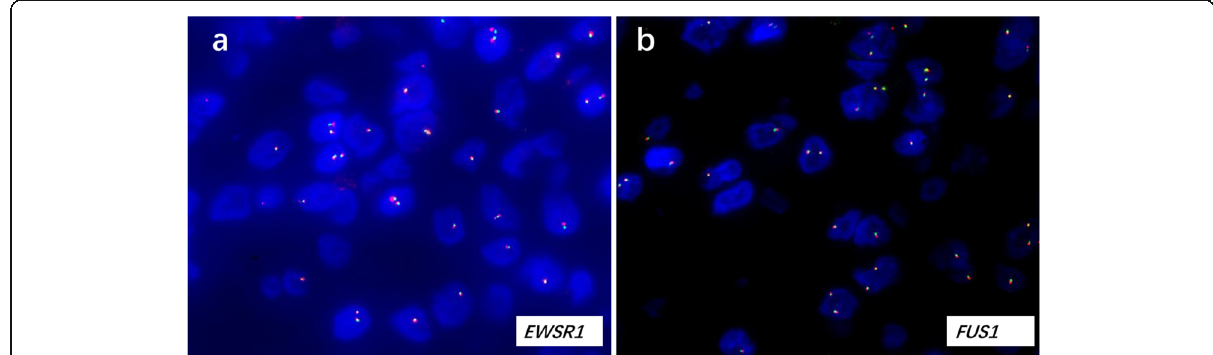
Fig. 3 FISH results of present case. The tumor cells exhibited two pairs of fused signals by ( a ) EWSR1 and ( b ) FUS1 probes, no split signals were